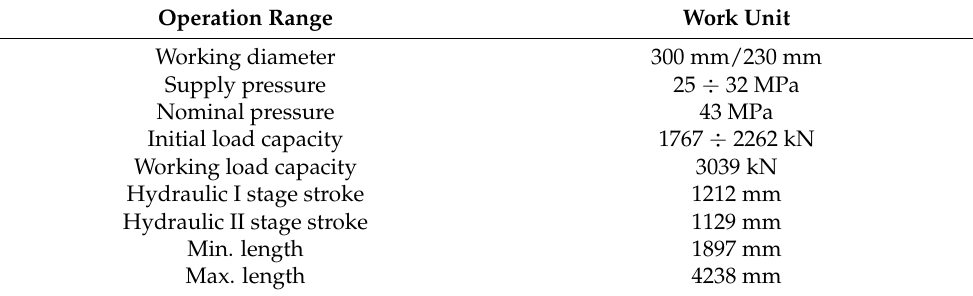
Table 1. Technical characteristics of the hydraulic prop of the powered roof support.